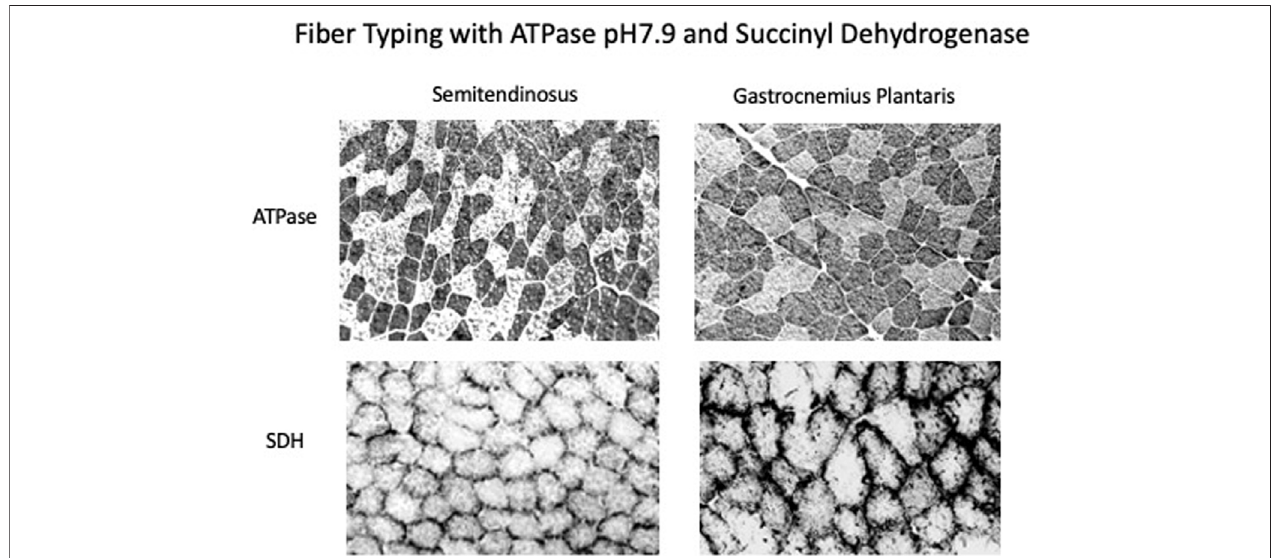
FIGURE 6 | Immunostaining of muscle sections with ATPase, pH7.9 which measures the potential speed of the muscle and succinate dehydrogenase which measures the oxidative capacity. Both the semitendinosus and gastrocnemius plantaris have a mosaic of fast and slow high oxidative fi bers.